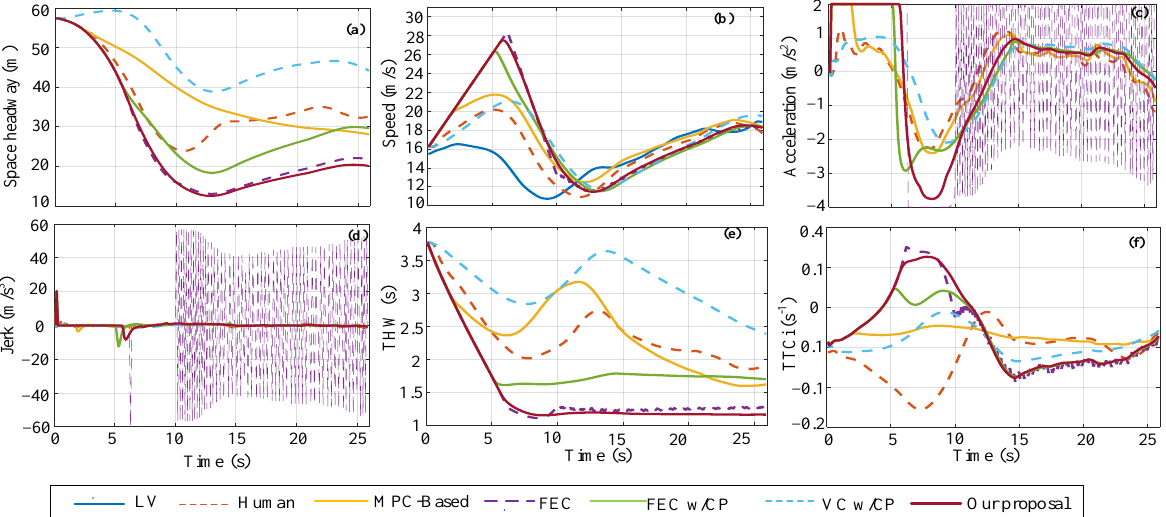
Figure 11. Comparison of decision performance of different strategies in single-scenario test set, where ( a – f ) respectively correspond to space headway, speed, acceleration, jerk, THW, and TTCi.